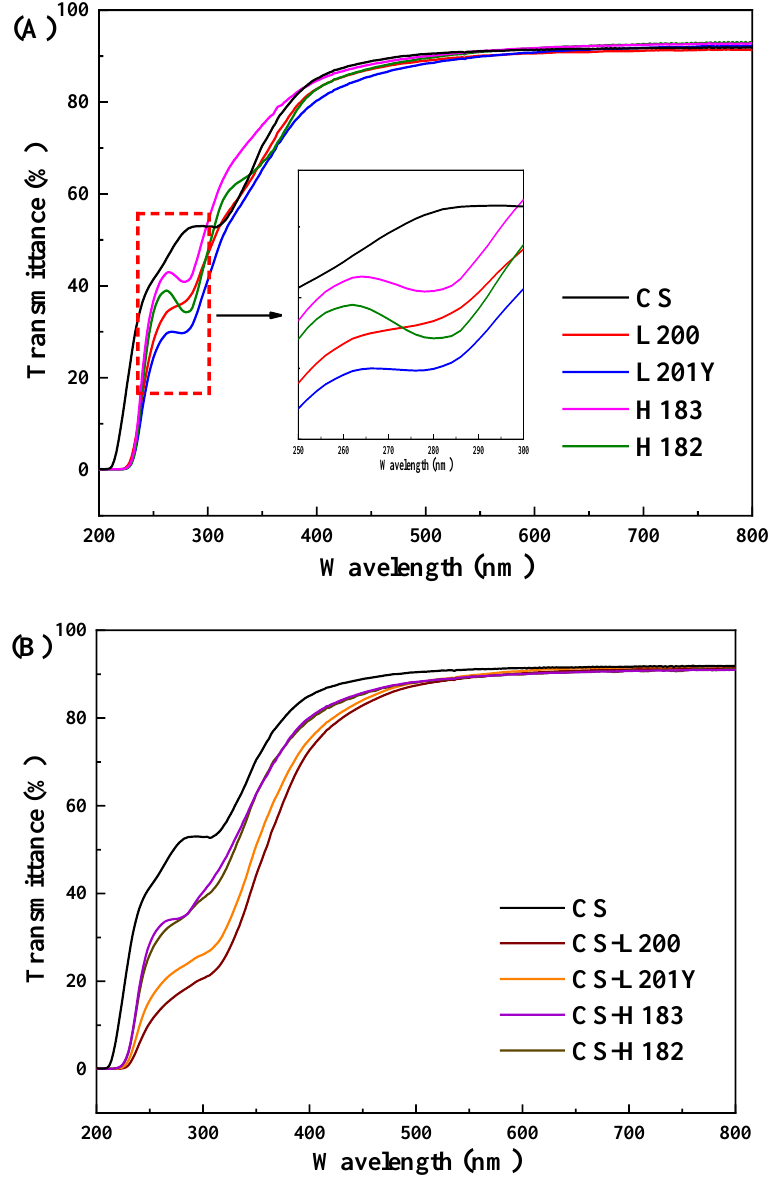
Figure 2. UV-vis transmittance of different monolayer ( A ) and bilayer ( B ) films. The subfigure of ( A ) was enlarged interpretation of the intersection regions of UV-vis transmittance curves from 250 to 300 nm.